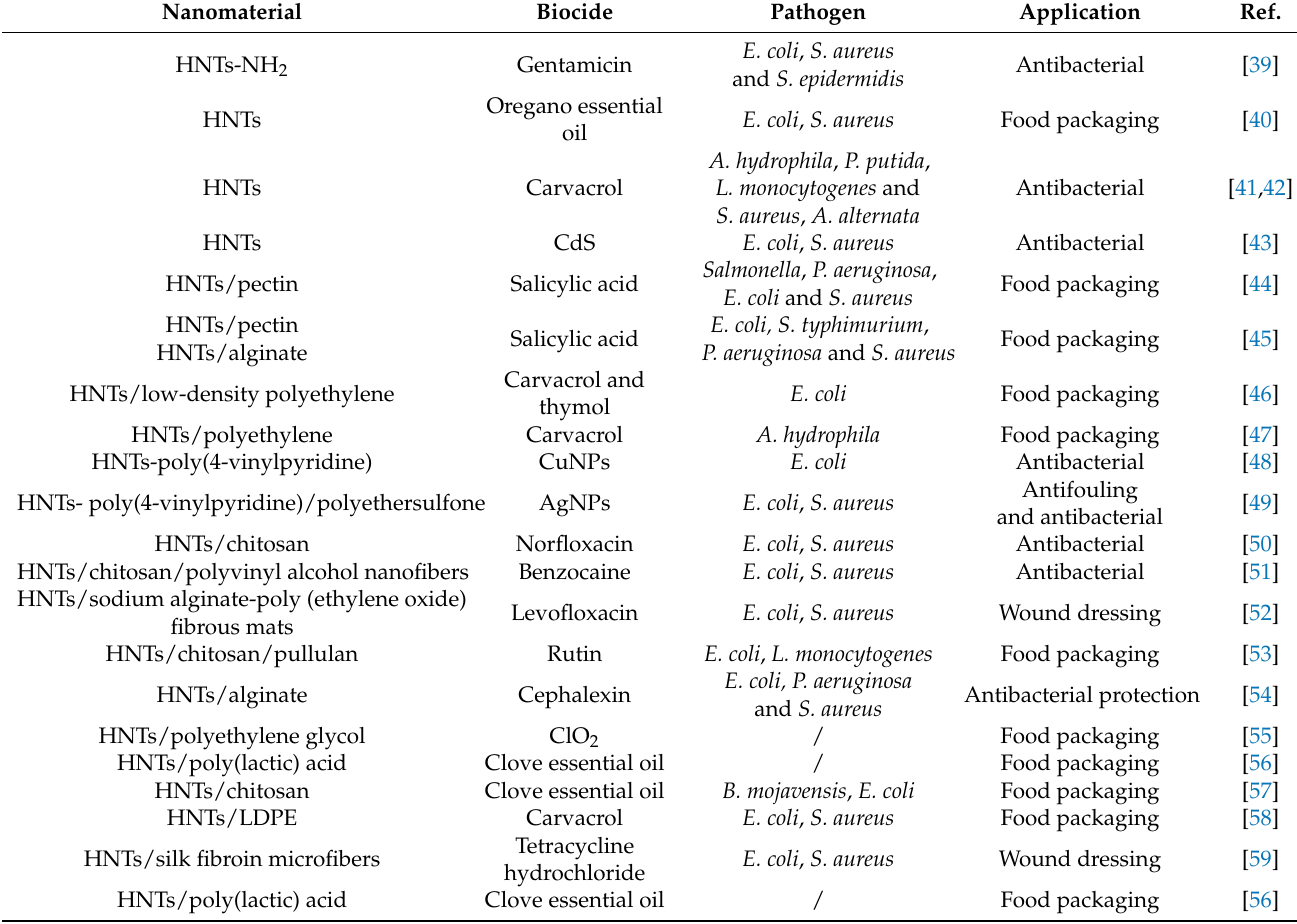
Table 1. Different HNTs based antimicrobial nanomaterials and their relative